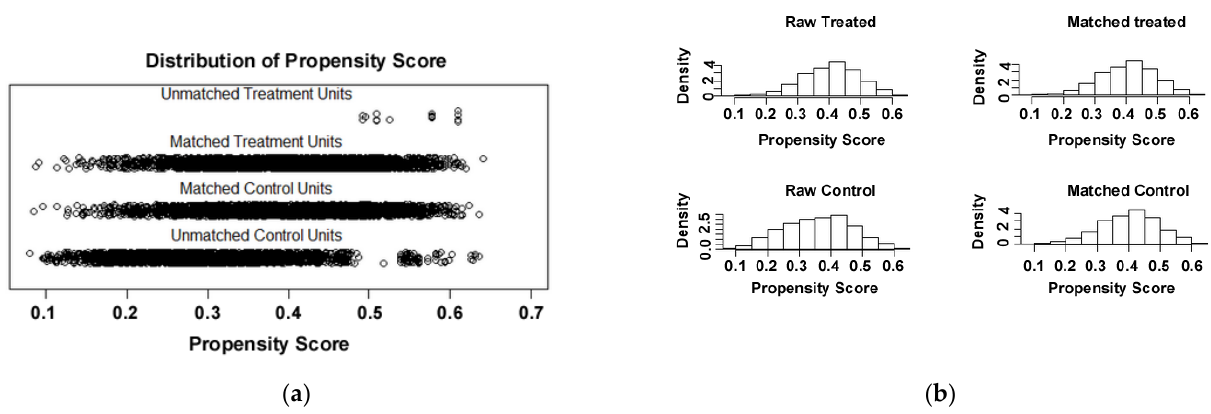
Figure 3. ( a ) Distribution map of the propensity score before and after matching. ( b ) Histogram of the propensity score before and after matching. Treated: Sub-DLBCL; Control: Sup-DLBCL.